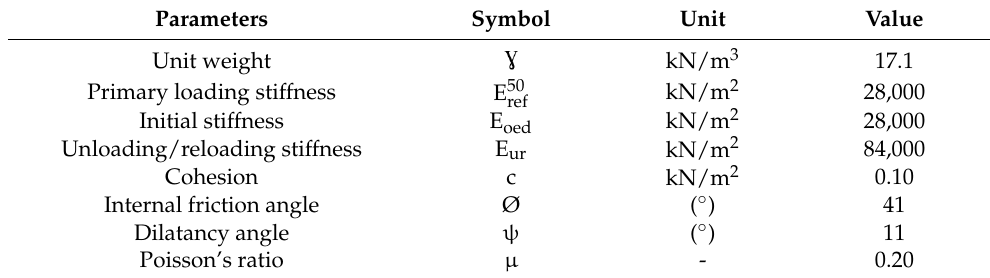
Table 5. Parameters of HS